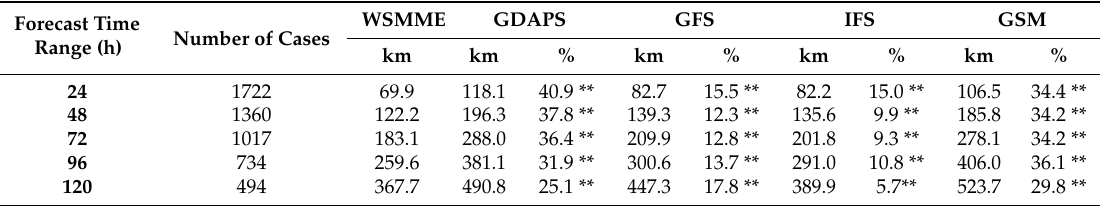
Table 3. Mean track forecast errors (km) of WSMME and each model during 2012–2015. WSMME’s skill scores (%) is relative to each model.